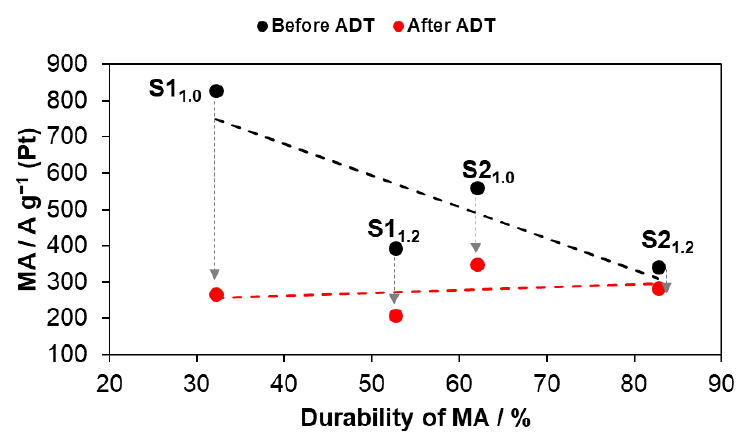
Figure 5. The dependence of the mass activity on the durability of the PtCu/C